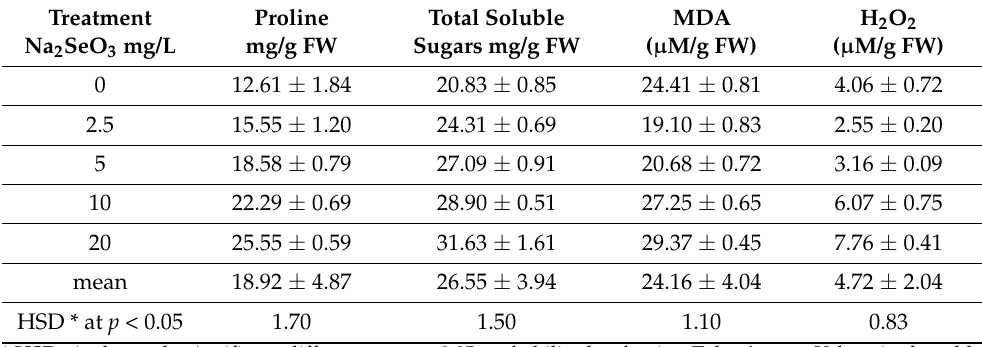
Table 3. Effect of various selenium levels (Na 2 SeO 3 ) on proline, soluble sugars, malondialdehyde (MDA), and hydrogen peroxide (H 2 O 2 ) content of quinoa plants after 30 days of selenium treatment. Number of samples 15:5 replications and 3 biological replicates.